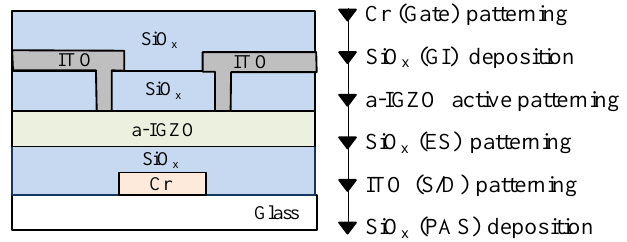
Figure 1. Device architecture and preparation process of the ITZO TFT.